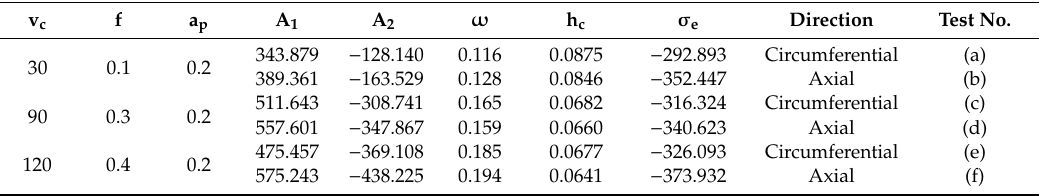
Table 7. The predicted key parameters of the residual stress prediction function ( v c : cutting speed in m / min; f : feed rate in mm / r; a p : depth of cut in